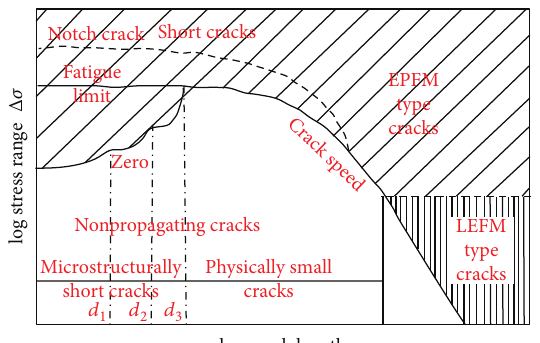
Figure 1: A modified Kitagawa-Takahashi Δ𝜎 - 𝑎 diagram, showing boundaries between MSCs and PSCs and between EPFM cracks and LEFM cracks [69,